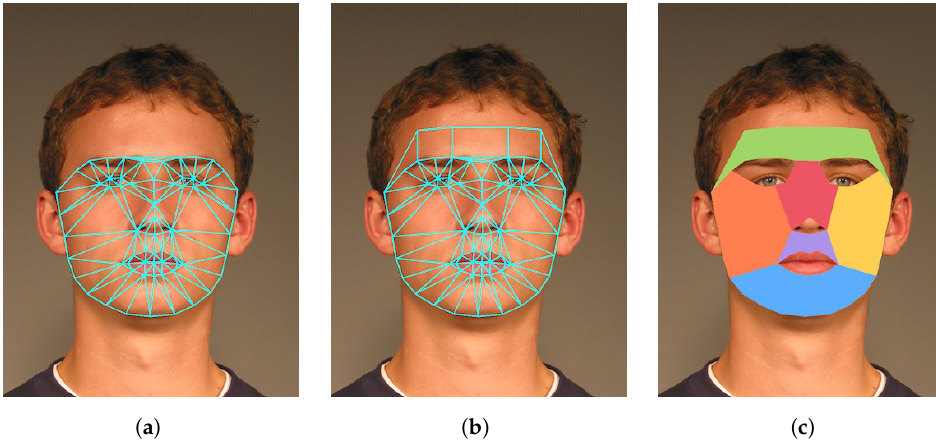
Figure 4. ( a ) Division of a facial image into regions from landmarks, ( b ) extended to the forehead, and ( c ) division into six pre-defined